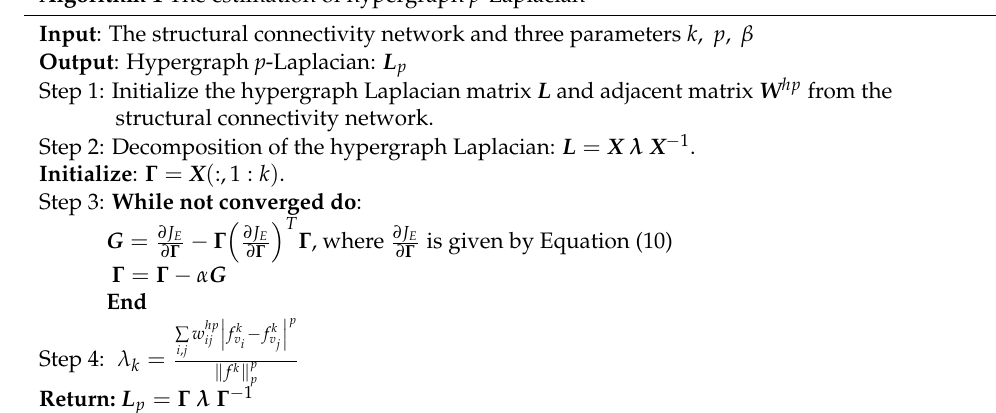
Algorithm 1 The estimation of hypergraph p